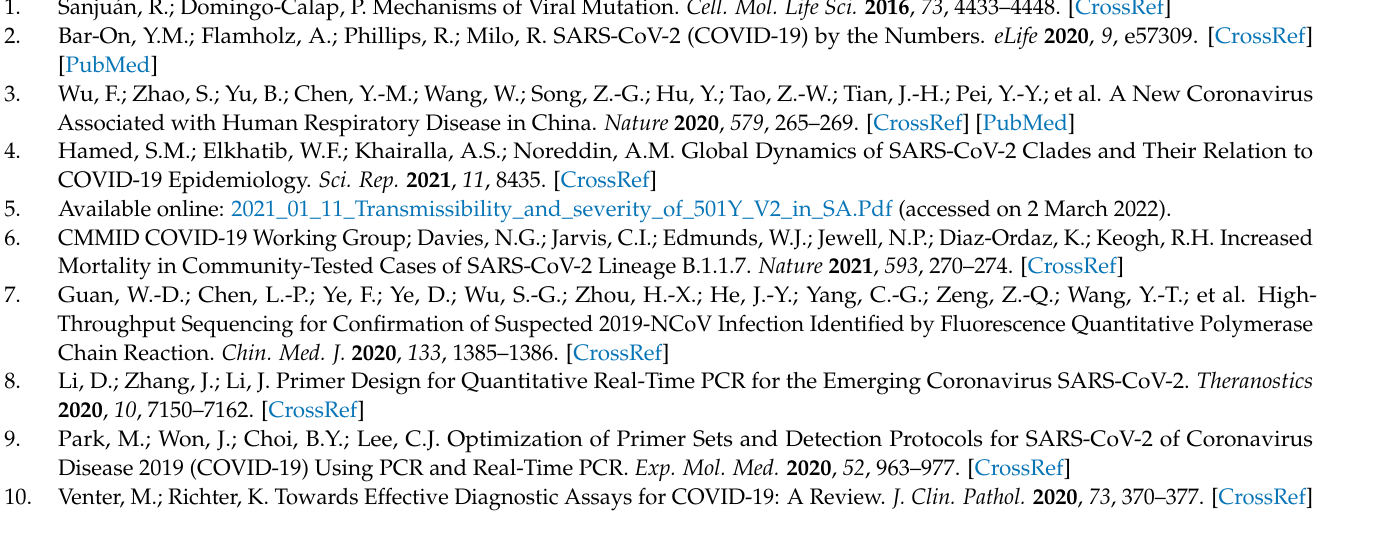
Table S6: Frequency of reference kmers across lineage-specific conservation landscapes; Table S7: Frequency of reference kmers across lineage-specific conservation landscapes for primer regions; Figure S1: Conservation landscape frequency over time for mutations of interest;